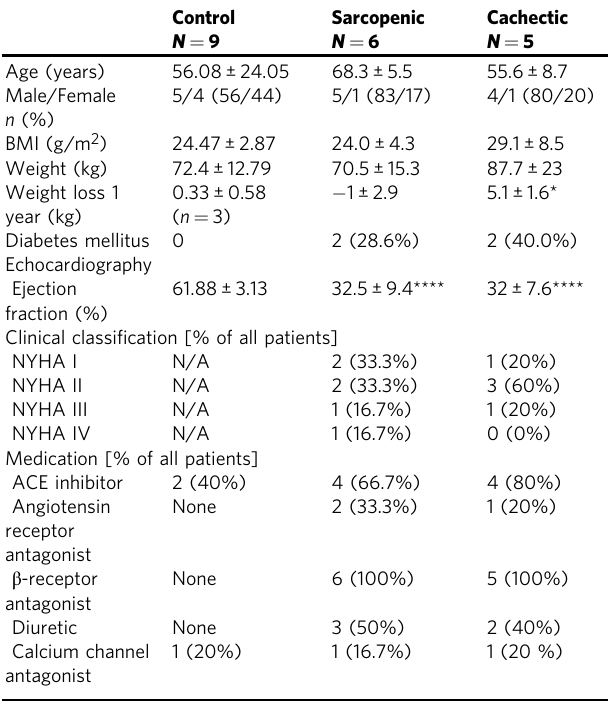
Table 1 Clinical characteristics of the patients or control individuals, who received a muscle biopsy.